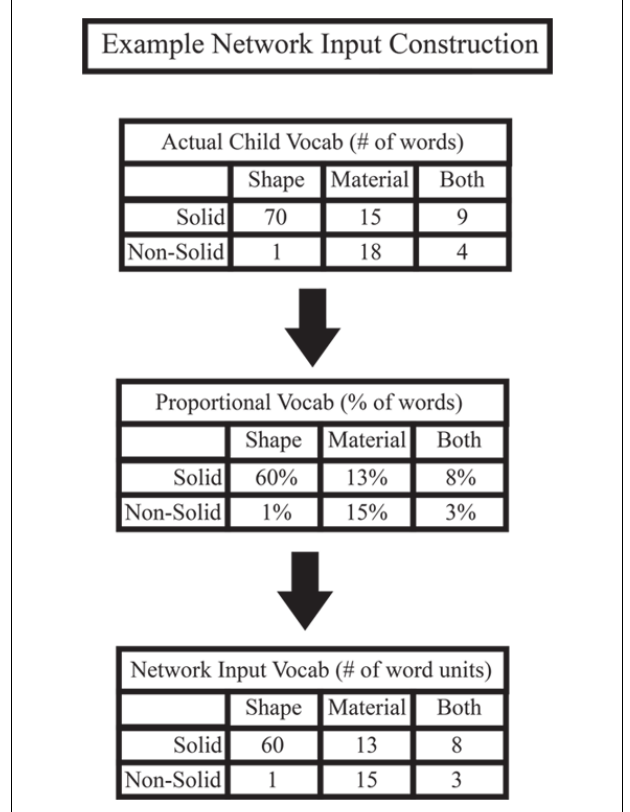
FIGURE 4 | Example of how our network input is constructed from children’s vocabulary data. First, the nouns that children know from the MCDI are broken into the six categories of interest.These raw numbers are then turned into percentages, normalized by the total number of nouns a child knows.This intermediate representation best illustrates what we mean by vocabulary structure. Finally, these percentages are used to create 100 noun representations that are used as training input for the